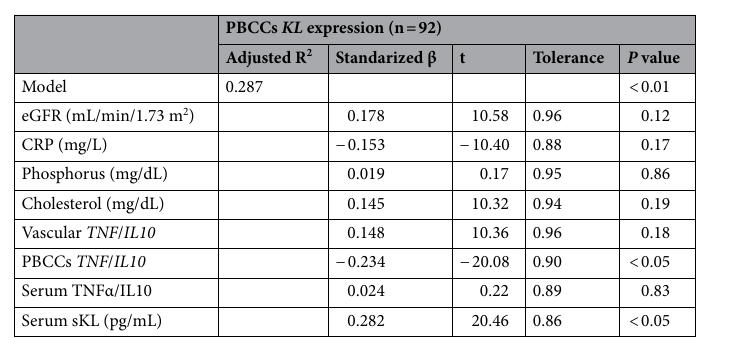
Table 3. Multiple regression analysis for KL expression in PBCCs as dependent